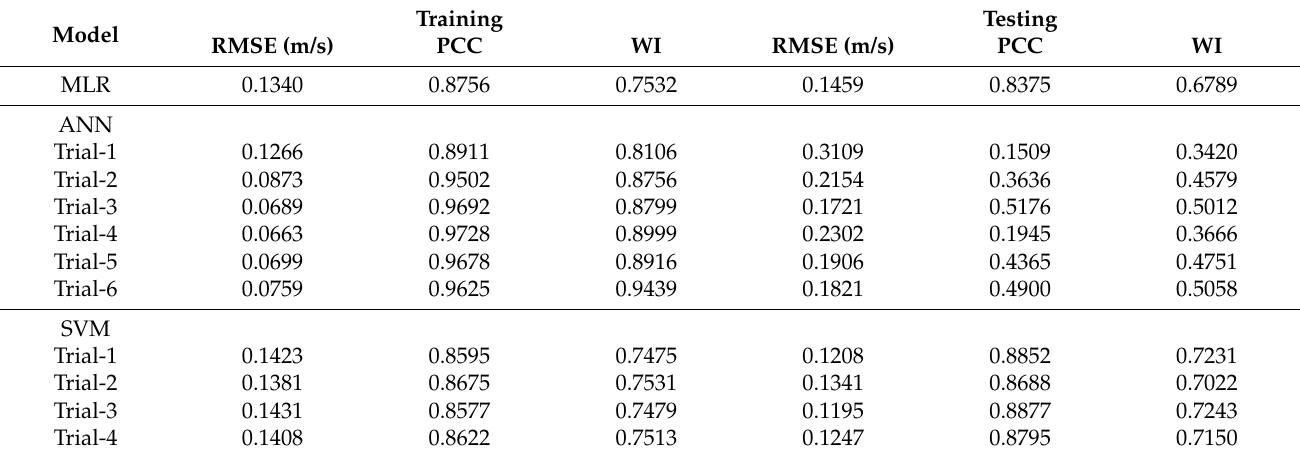
Table 2. During the training and testing phase, performance evaluations of MLR, ANN, and SVM